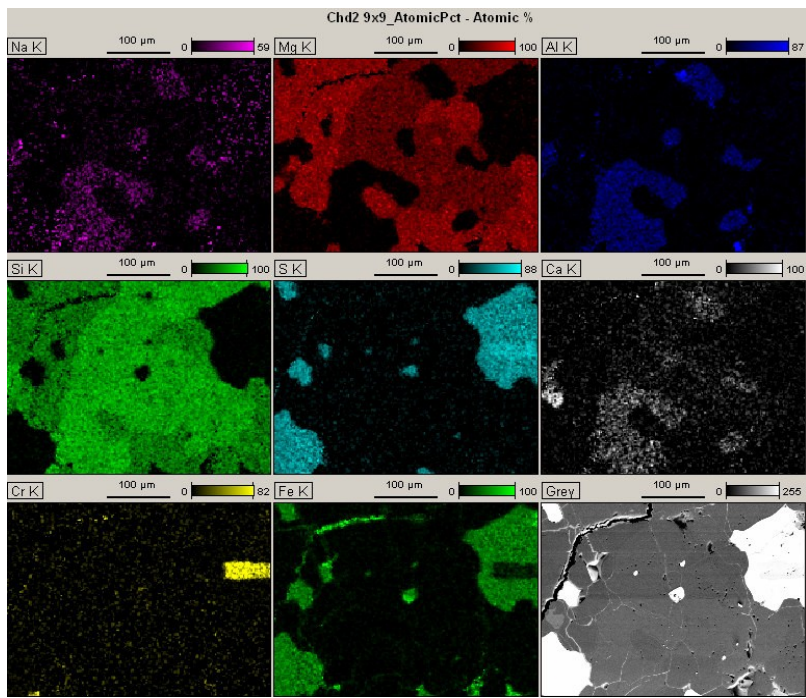
Figure 1. BSE scanning electron photomicrograph (bottom right) and X-ray